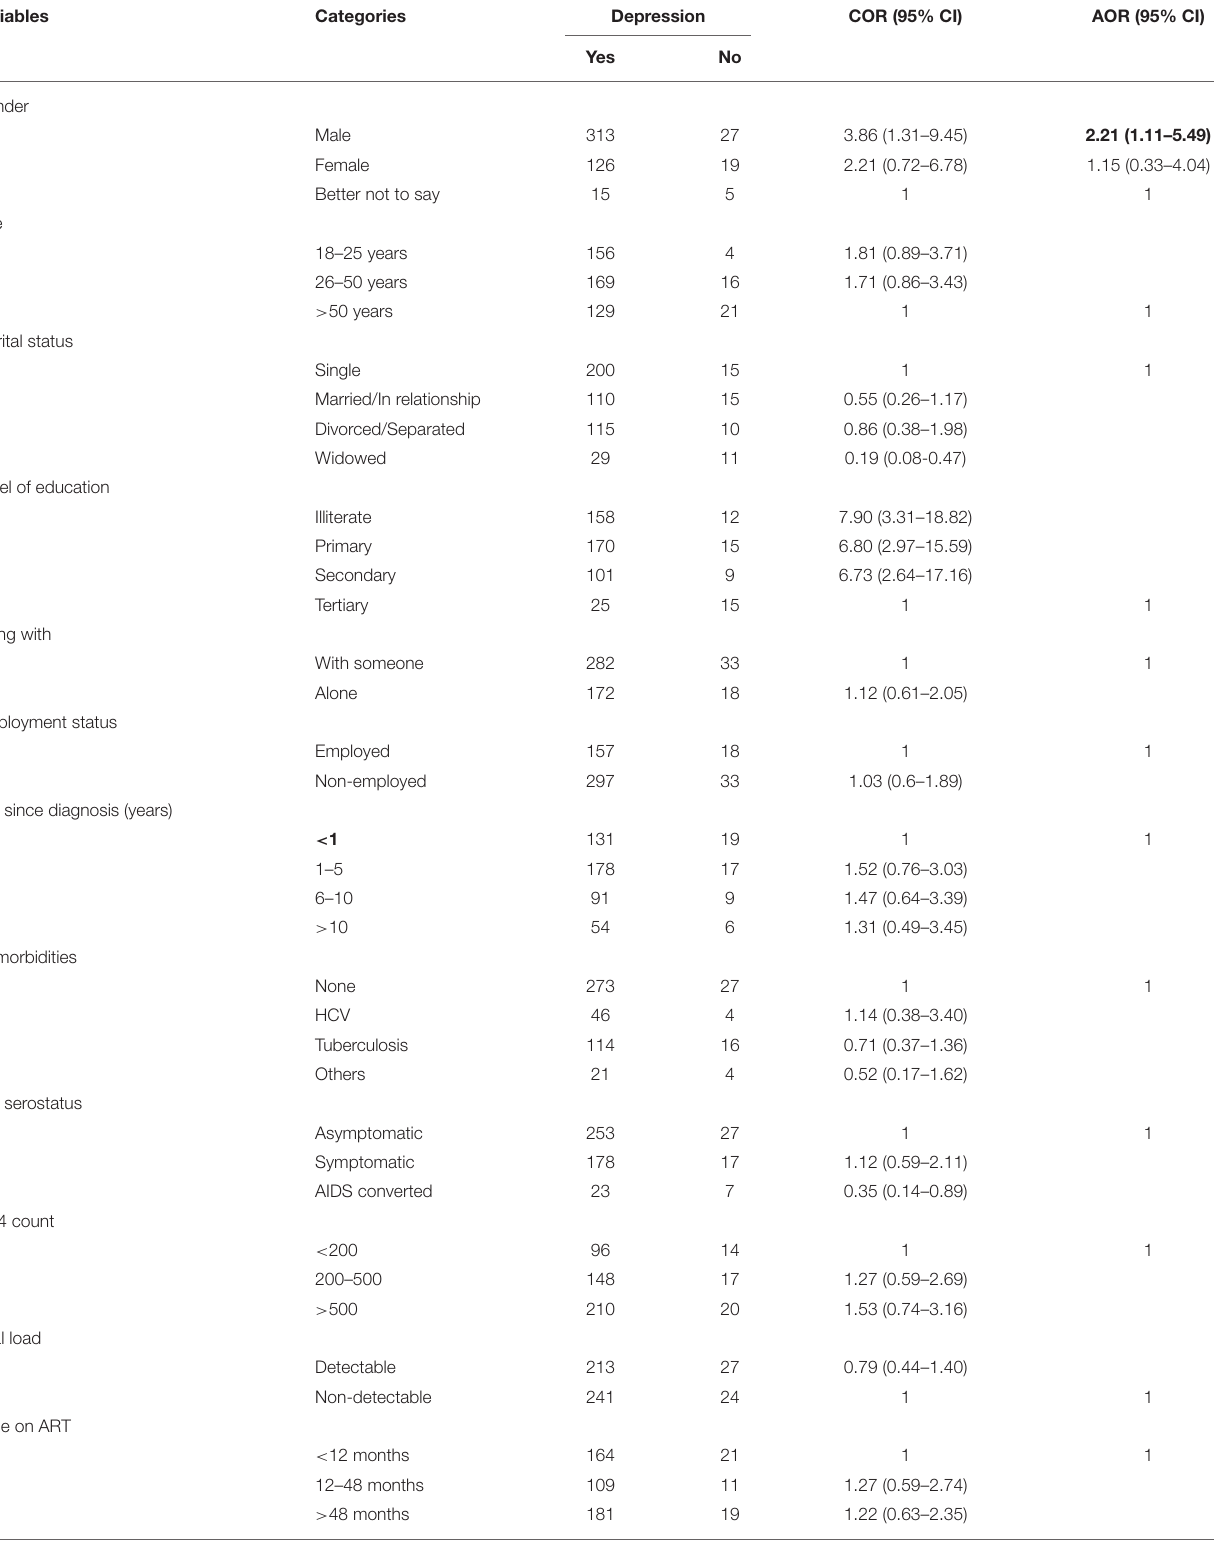
TABLE 3 | Factors associated with